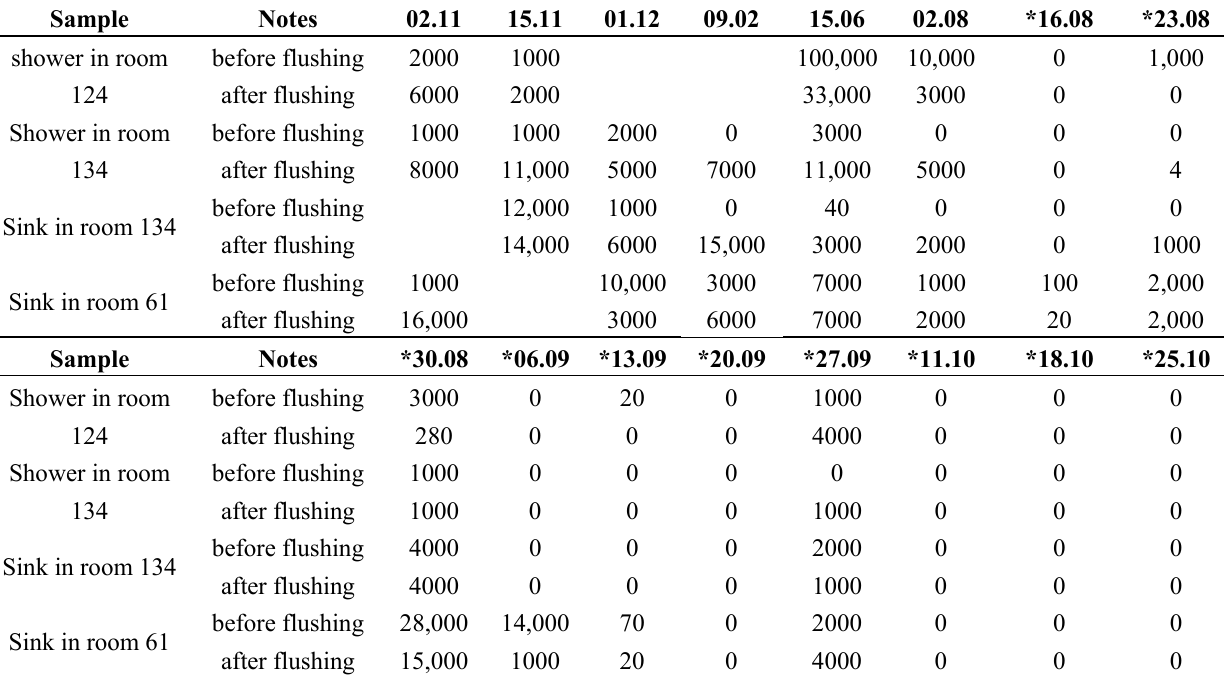
Table 1. Selection of data on Legionella detection (values expressed in colony-forming units (CFU)/L); Department of Neurology, Dresden University Hospital. Asterisks refer to withdrawals performed with the electrochemical technology implemented in the water system (the electrochemical technology was put into operation on